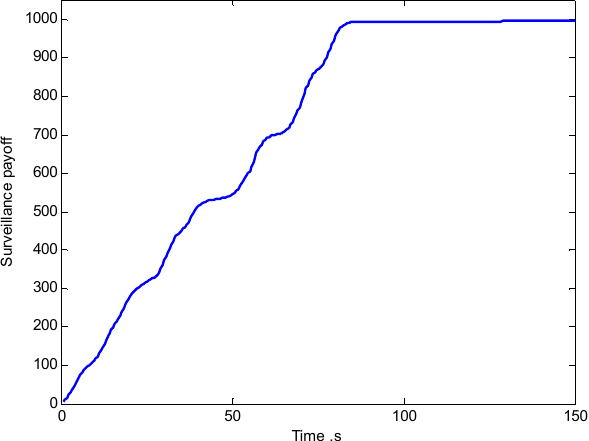
Figure 7. Surveillance payoff in multi UAVs cooperative surveillance.